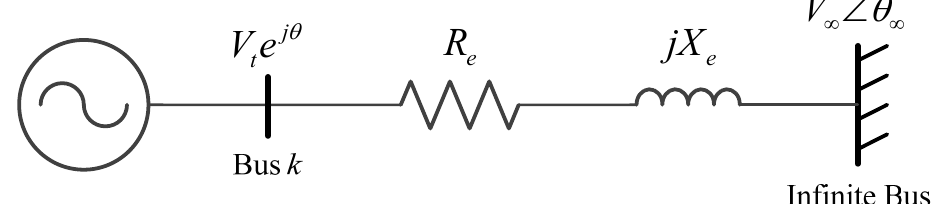
Figure 3. Single machine infinite bus (SMIB)